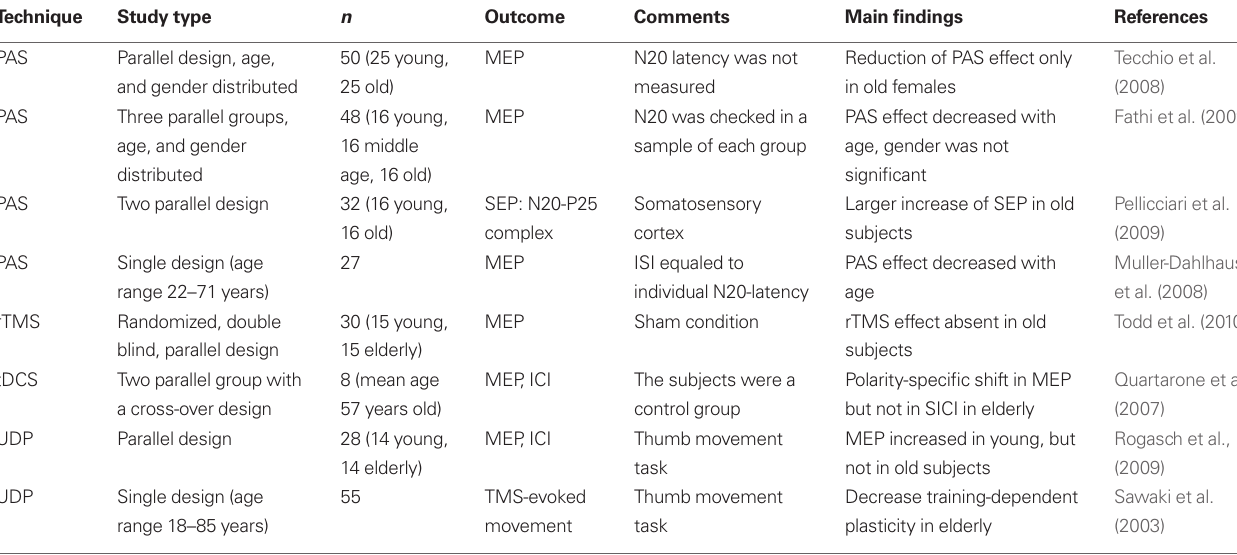
Table 2 | Induction of neuro-plasticity in old healthy